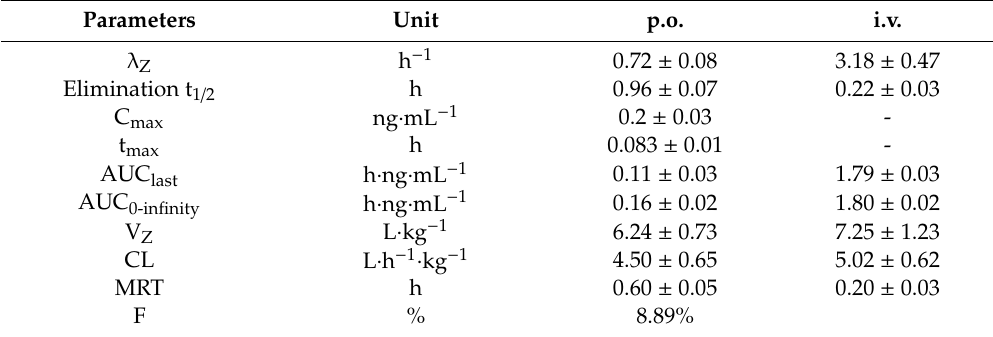
Table 1. The integrated toxicokinetic parameters of ZEN-14G in rats after p.o. and i.v. administration at a dose of 0.75 mg / kg body weight using non-compartmental analysis. The results are shown as mean ± standard deviation ( n =